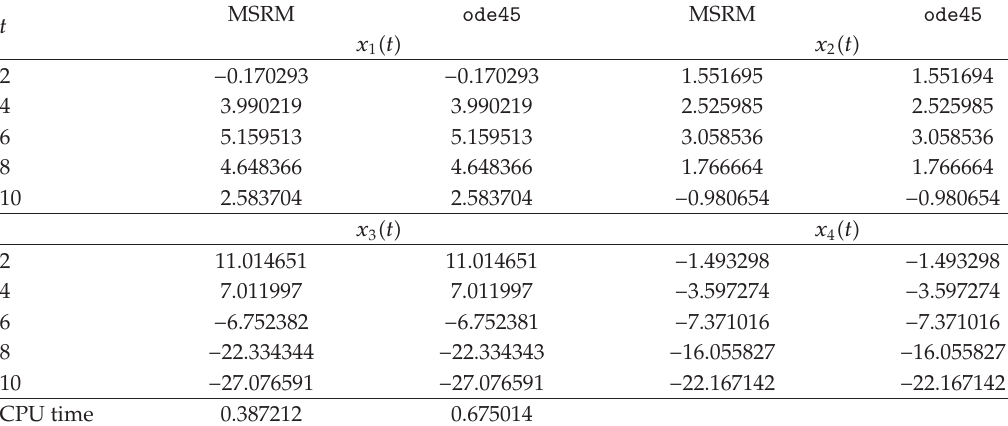
Table 1: Comparison of the numerical solution of the hyperchaotic Chua system obtained by the MSRM and ode45